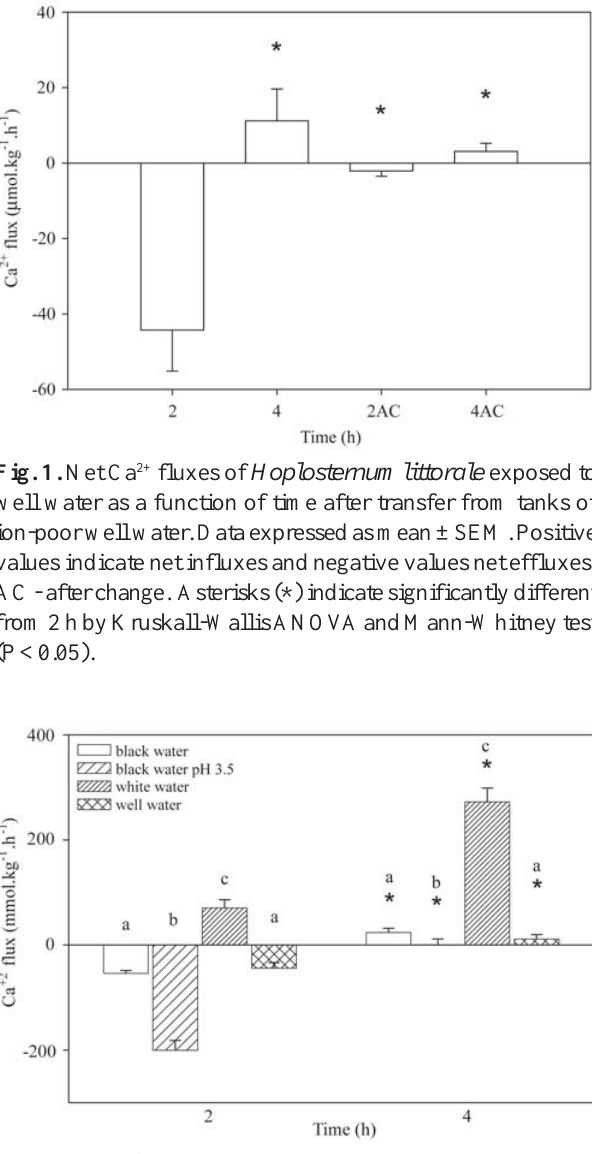
Fig. 2. Net Ca 2+ fluxes of Hoplosternum littorale transferred from tanks of ion-poor well water to experimental flux chambers containing different Amazonian waters. The first four bars show fluxes measured over the first 2 hours, and the second set of four bars show data for the 2-4 h period after initial transfer. Data expressed as mean ± SEM. Positive values indicate net influxes and negative values net effluxes. Different letters indicate significant differences among groups in the same period of time by Kruskall-Wallis ANOVA and Mann- Whitney test (P < 0.05). Asteriks (*) indicate significantly different from the same group at 2 h (P